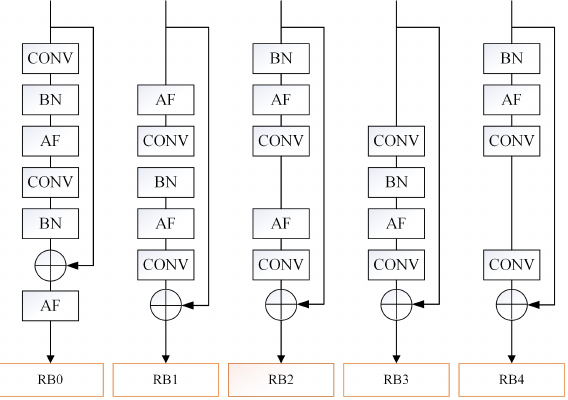
Figure 6. Residual block structures.